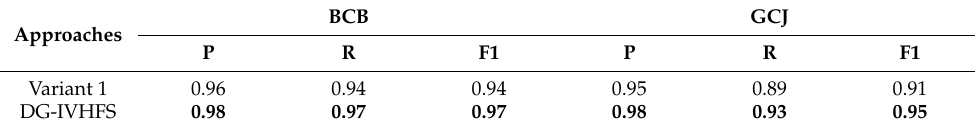
Table 3. The ablation experiment results on BCB and GCJ of group representations.